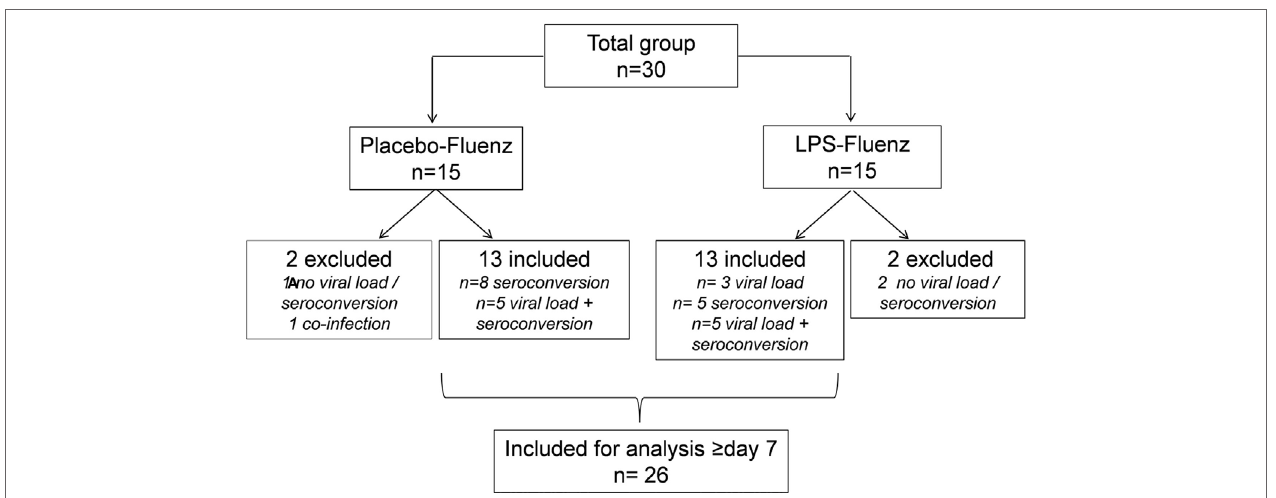
FigUre 2 | Flowchart based on infectivity, defined as positive viral load for at least one of the influenza strains >day 7 and/or seroconversion (≥4-fold increase in antibody titer for at least one of the influenza strains at day 28 postvaccination compared with baseline). One subject in the placebo–Fluenz group became positive again for one of the influenza strains and was therefore considered to have a co-infection with influenza virus. This subject was excluded for further